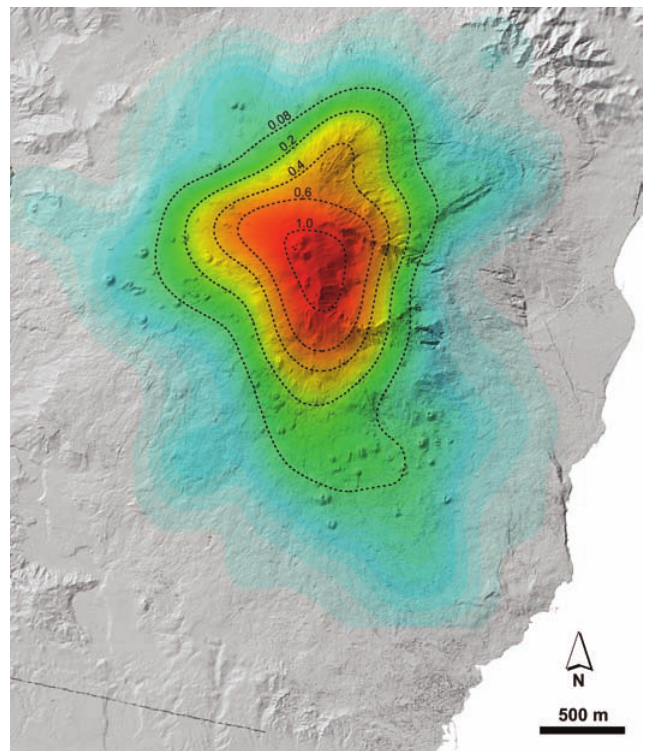
Figure 4. Probability density function for vent opening. Colors correspond to different probability density values expressed as percentages per square kilometer (black dashed contours are